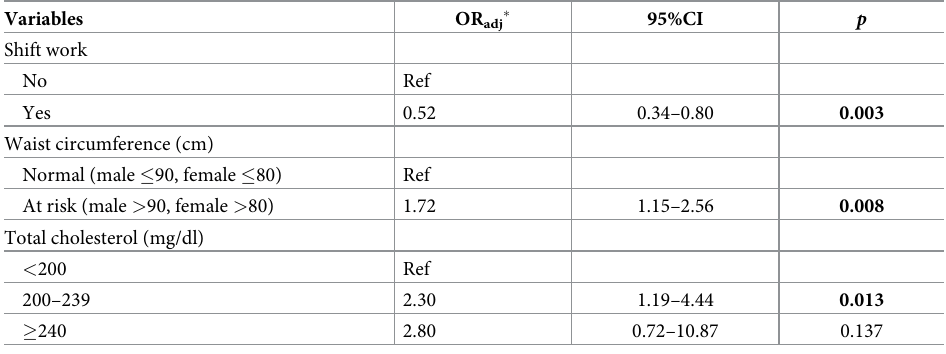
Table 4. Risk factors associated with COVID-19 among university employees ( n = 605).